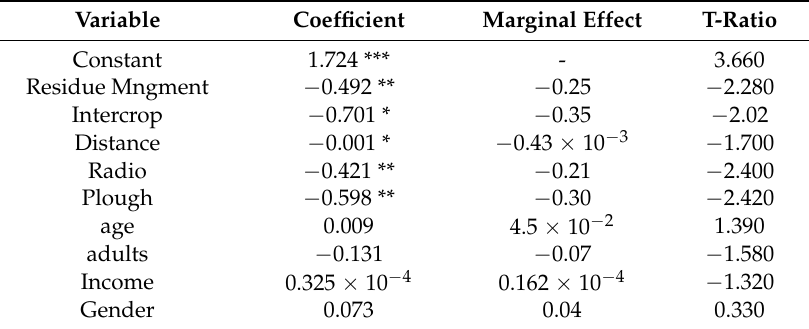
Table 5. Results of the determinants of technical